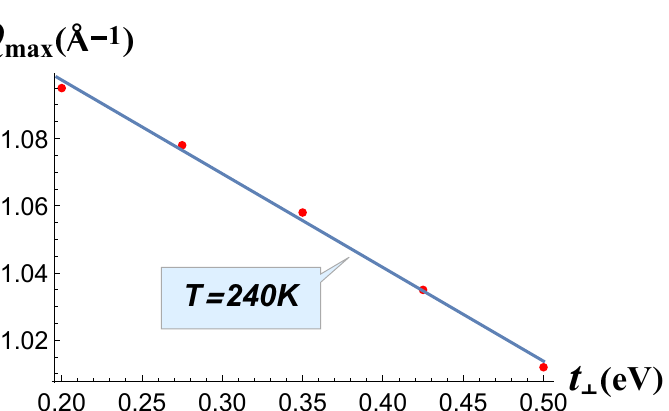
Figure 1. CDW 1 (charge-density wave) vector Q max calculated at T = 240 K as a function of the electron hopping term t ⊥ .